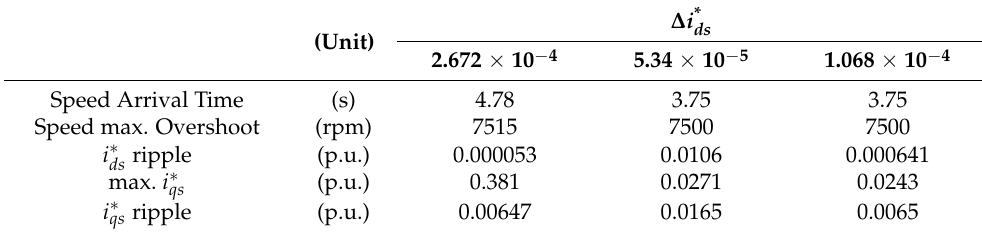
Table 3. Summary of simulation results when speed command is 2000 rpm.